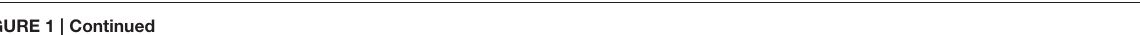
FIGURE 1 | Continued confidence levels are shown, spectral power law ω − 2 is denoted by a thin solid black line, shaded areas indicate diurnal (D) and semidiurnal (SD) tidal frequency bands shown in plots below. (B) High-resolution diurnal and semidiurnal spectra for Stockholm and Kronstadt, the Baltic Sea; main tidal peaks are indicated. (C) The same for Tuapse and Odessa, the Black Sea. (D) The same for Aladga and Makhachkala, the Caspian Sea. (E) The equilibrium response R j , i.e., the ratio of observed and theoretical amplitudes of diurnal and semidiurnal tidal constituents for six selected “deep-sea” (left) and “shallow-water” (right)